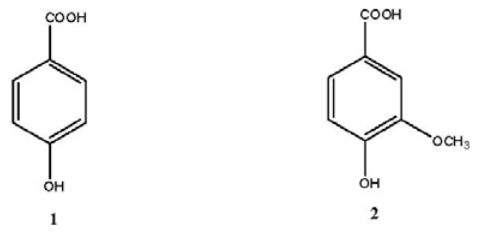
Figure 3. Structures of compounds 1-2